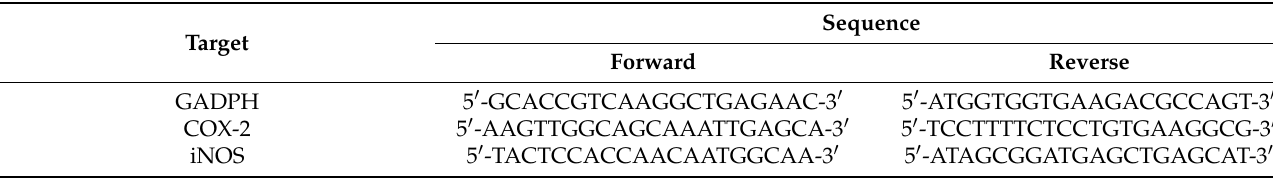
Table 1. PCR primer sequences used in this study.